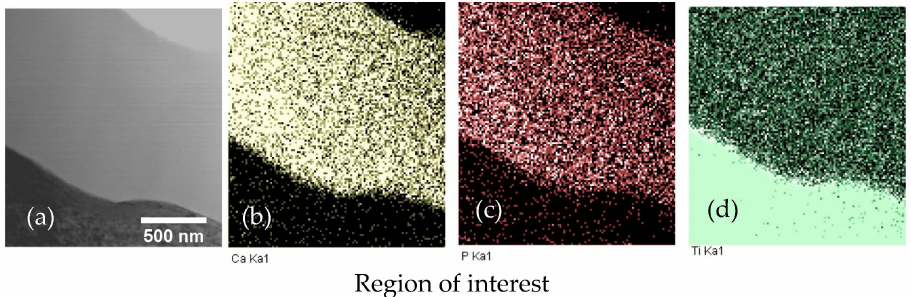
Figure 5. Energy-dispersive X-ray (EDX) element mapping of CaP coating on Ti–6Al–7Nb substrate in TEM lamella: ( a ) ROI in STEM; ( b ) Ca Ka1; ( c ) P Ka1; ( d ) Ti Ka1.